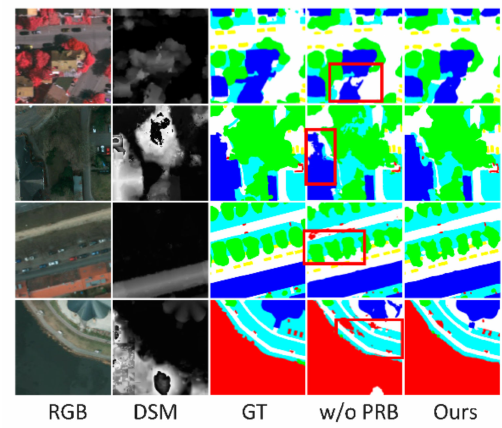
Figure 4. Ablation performance comparisons with the effect of